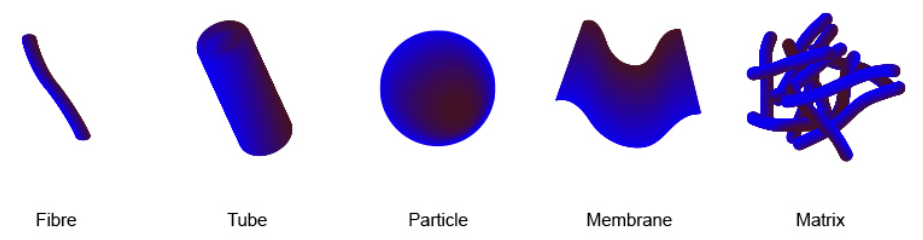
Figure 1. Types of nanomaterials used in the drug delivery system based on peptides. Based on [4].